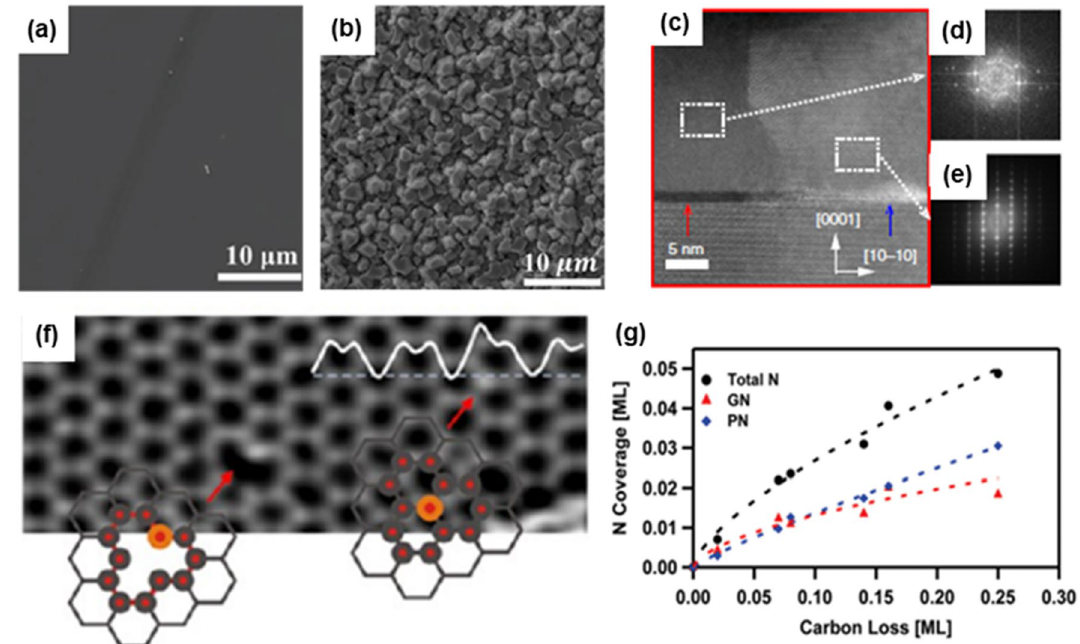
Fig. 9 Plan‑view SEM image of GaN growth on graphene/SiO 2 /Si substrate. a with NH 3 annealing b without NH 3 annealing. Figure reproduced from ref. [217], Wiley. c cross‑sectional HAADF‑STEM image of GaN on N‑plasma treated graphene/SiC substrate. FFT pattern of AlN layer grown on d graphene regime, e etched graphene regime. Figure reproduced from ref. [218], Springer Nature Ltd. f atomic resolution HAADF‑STEM image of graphene layer after N ion implantation showing N‑atom adjacent to a vacancy and a substitutional N‑atom. Figure reproduced from ref. [219], ACS Publications. g Demonstration that carbon loss of graphene is proportional to N coverage. Figure reproduced from ref. [220], ACS